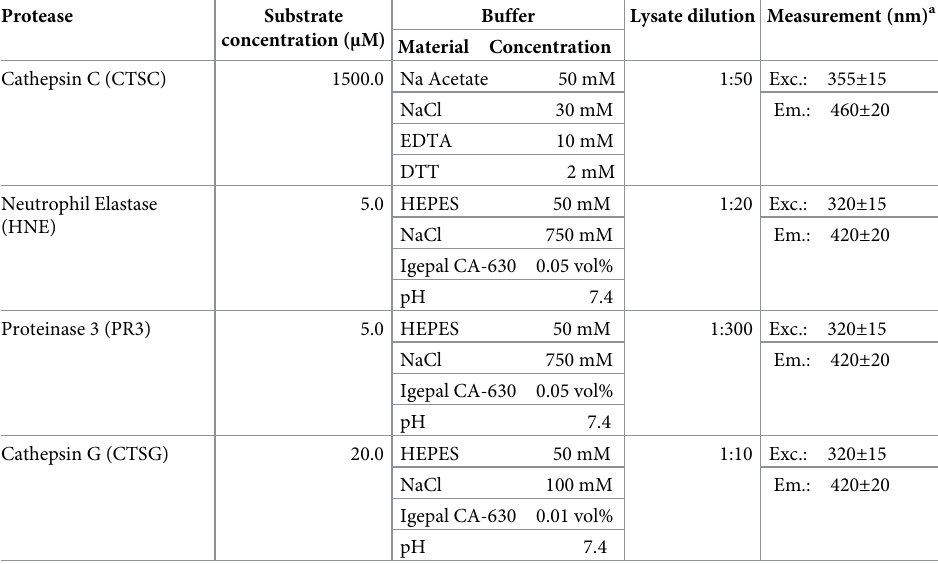
Table 1. Parameters for protease activity assay.